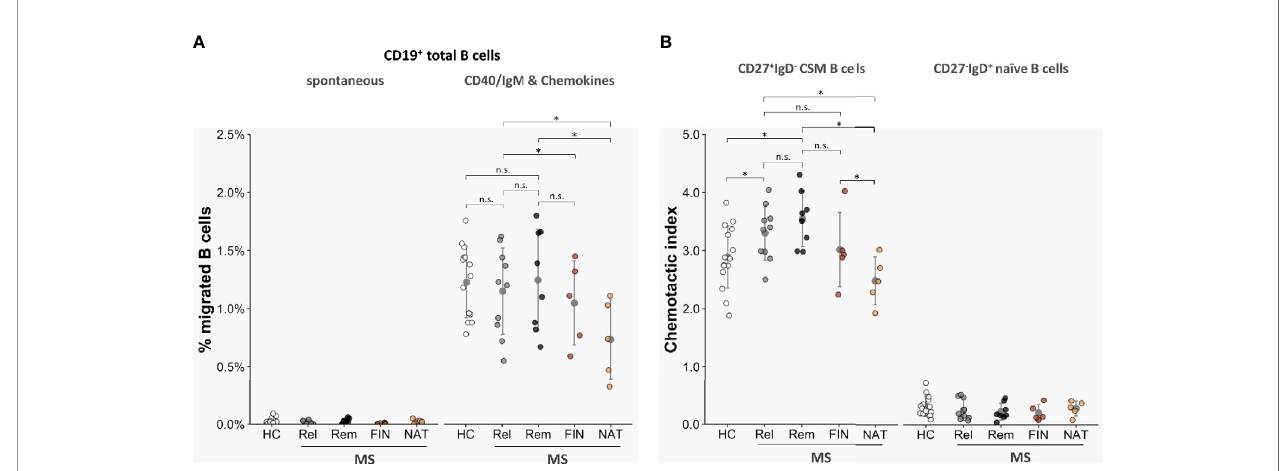
FIGURE 4 | Transmigration of MS-derived B-cell subsets across HIBCPP cells. Chemotactic activities of CD19 + total B cells, CD19 + CD27 + IgD - class-switched memory B cells (CSM), and CD19 + CD27 - IgD + naive B cells isolated from peripheral blood of 15 healthy donors (HC) and 28 MS patients (untreated, in relapse: n = 10 (Rel); untreated, in remission: n = 8 (Rem); fi ngolimod-treated: n = 5 (FIN); natalizumab-treated: n = 5 (NAT)). (A) TM rates of total CD19 + B cells derived from treatment-naïve MS patients were not altered compared with controls, but where signi fi cantly lower when obtained from NAT-treated patients. (B) Overall, chemotactic indices (CI) of CSM B cells were clearly higher than those of CD27 - naïve B cells. CIs where further enhanced for CSM B cells derived from non-treated MS but were signi fi cantly lower when tested with CSM B cells obtained from NAT-treated individuals. All experiments were carried out in triplicates. Dots represent data per individuals. Means are indicated (grey circles). Error bars denote SD. Asterices indicate statistical signi fi cances compared with spontaneous TM (* P < 0.05, n.s., not signi fi cant; one-way ANOVA plus post Hoc Tukey